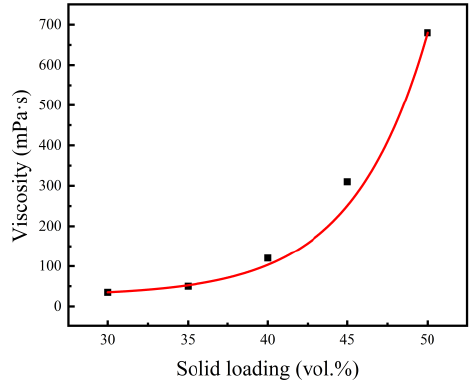
Figure 3. Influence of solid loading on the apparent viscosity of slurries.